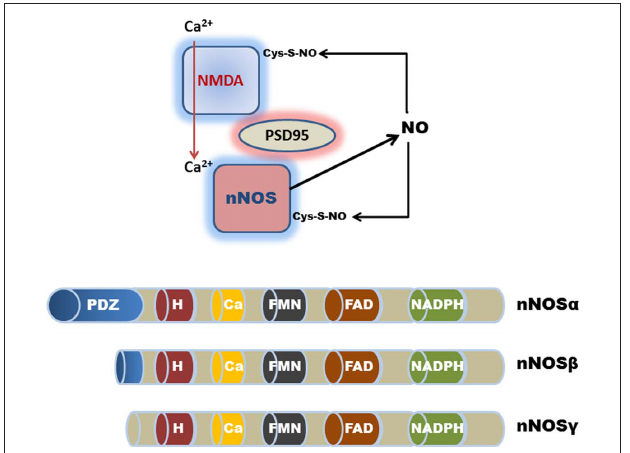
Figure 2 | Schematic representation (top) of nNOS PDZ domain- α interactions with PSD-95 and the NMDA receptor in the CNS. Calcium ion entry activates nNOS production of NO. Excessive NO production results in the auto-S-nitrosylation and inhibition of nNOS and the NMDA receptor. Although auto-S-nitrosylation of nNOS represents a likely inhibitory mechanism in the GI tract, a physiological role for NMDA receptor signaling remains controversial. (Bottom) Shows the various nNOS protein isoforms; nNOS contains a NH -terminus PDZ/GLGF-domain ( ∼ 100 amino acids), that 2 α modulates interactions with other PDZ-containing proteins. nNOS and nNOS β γ lack a PDZ domain; H, heme consensus site; Ca, calmodulin consensus site; FMN, flavin mononucleotide consensus site; and FAD, flavin adenine dinucleotide consensus